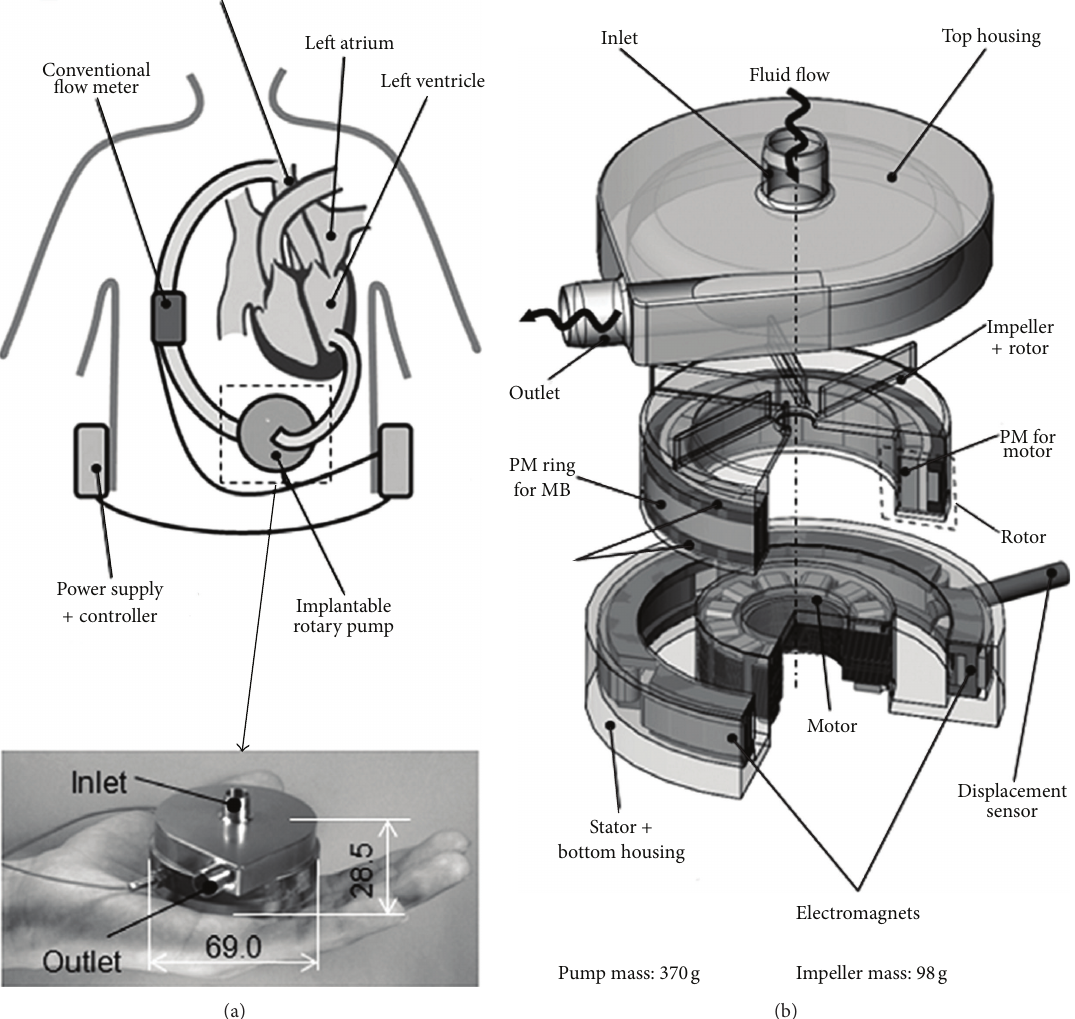
Figure 27: (a) Ventricular assist system and photograph of an implantable maglev CBP, and (b) configuration of the implantable maglev CBP.